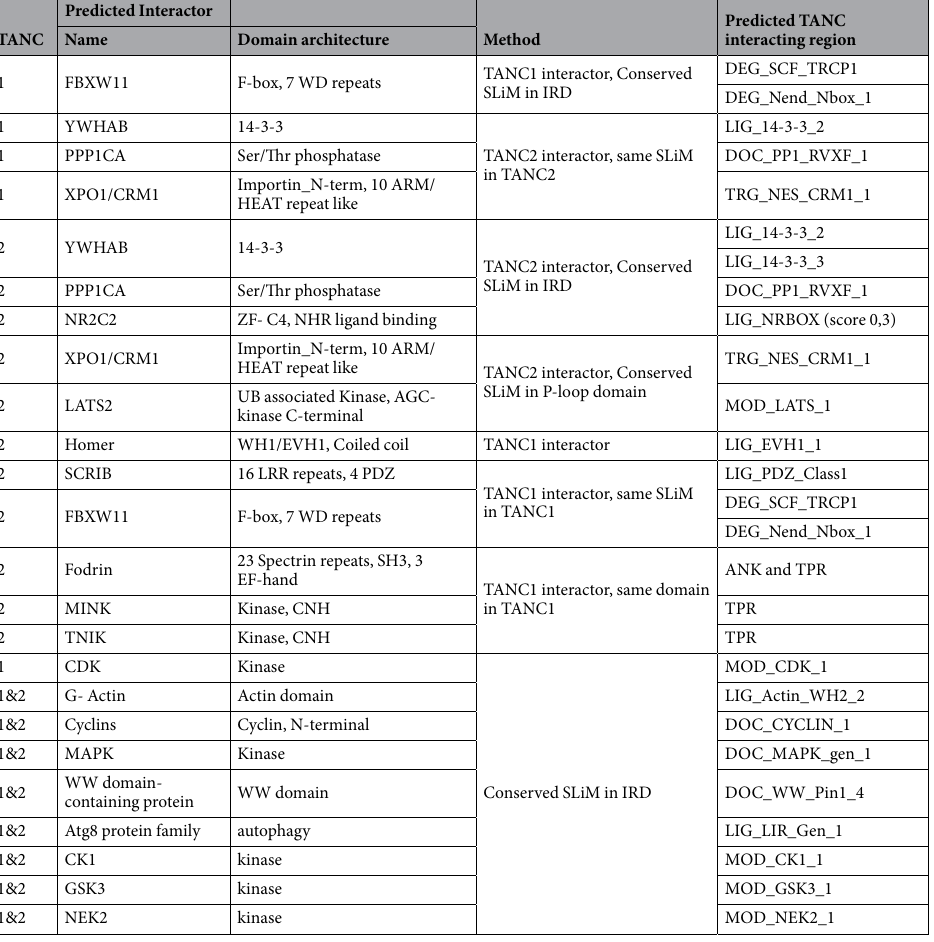
Table 2. Predictions for TANC interactors. For each interactor we searched for the putative domain or linear motifs predicted to mediate TANC interaction. We assume that if the known interactor is a class of protein or presents the domain known to bind a predicted TANC linear motif this may be the putative interactor binding site. SLiM: Short Linear motif; IDR: Intrinsically disordered region. SLiMs are named according to the ELM